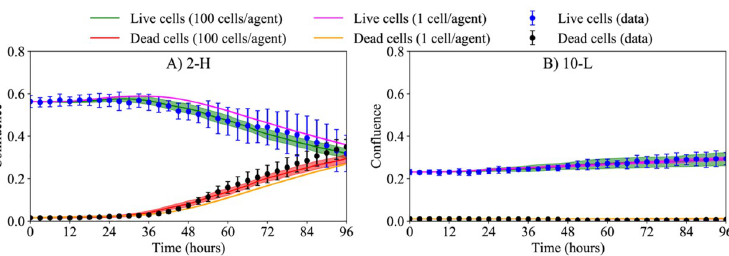
Fig 12. Comparison between the single-agent ABM using the parameter values from the cgABM, and the experimental data of scenarios 2-H and 10-L. Scenario-specific calibration of the cgABM to the time-resolved microscopy data for the 2 mM initial glucose concentration and high initial tumor cell confluence (panel A), and for the 10 mM initial glucose concentration and low initial tumor cell confluence (panel B). The data mean and 95% credible interval for the live and dead cells are shown in blue and black, respectively. The mean of the cgABM simulation is represented as a solid line, and the area is the 95% credible interval for the live (green) and dead (red) cells. The mean of the ABM simulation is represented as a solid line, and the area is the 95% credible interval for the live (magenta) and dead (orange) cells. The average error and standard deviation for live and dead cells, in the cgABM, in scenario 2-H are 6.43 ± 1.01% and 3.45 ± 1.15%, respectively. While that for the ABM using the parameter values of the cgABM are 8.19 ± 1.19% and 4.80 ± 1.50%, respectively. The average error and standard deviation for live and dead cells, in the cgABM, in scenario 10-L are 3.68 ± 0.52% and 1.84 ± 0.20%, respectively. While that for the ABM using the parameter values of the cgABM are 5.12 ± 0.63% and 1.96 ± 0.23%,